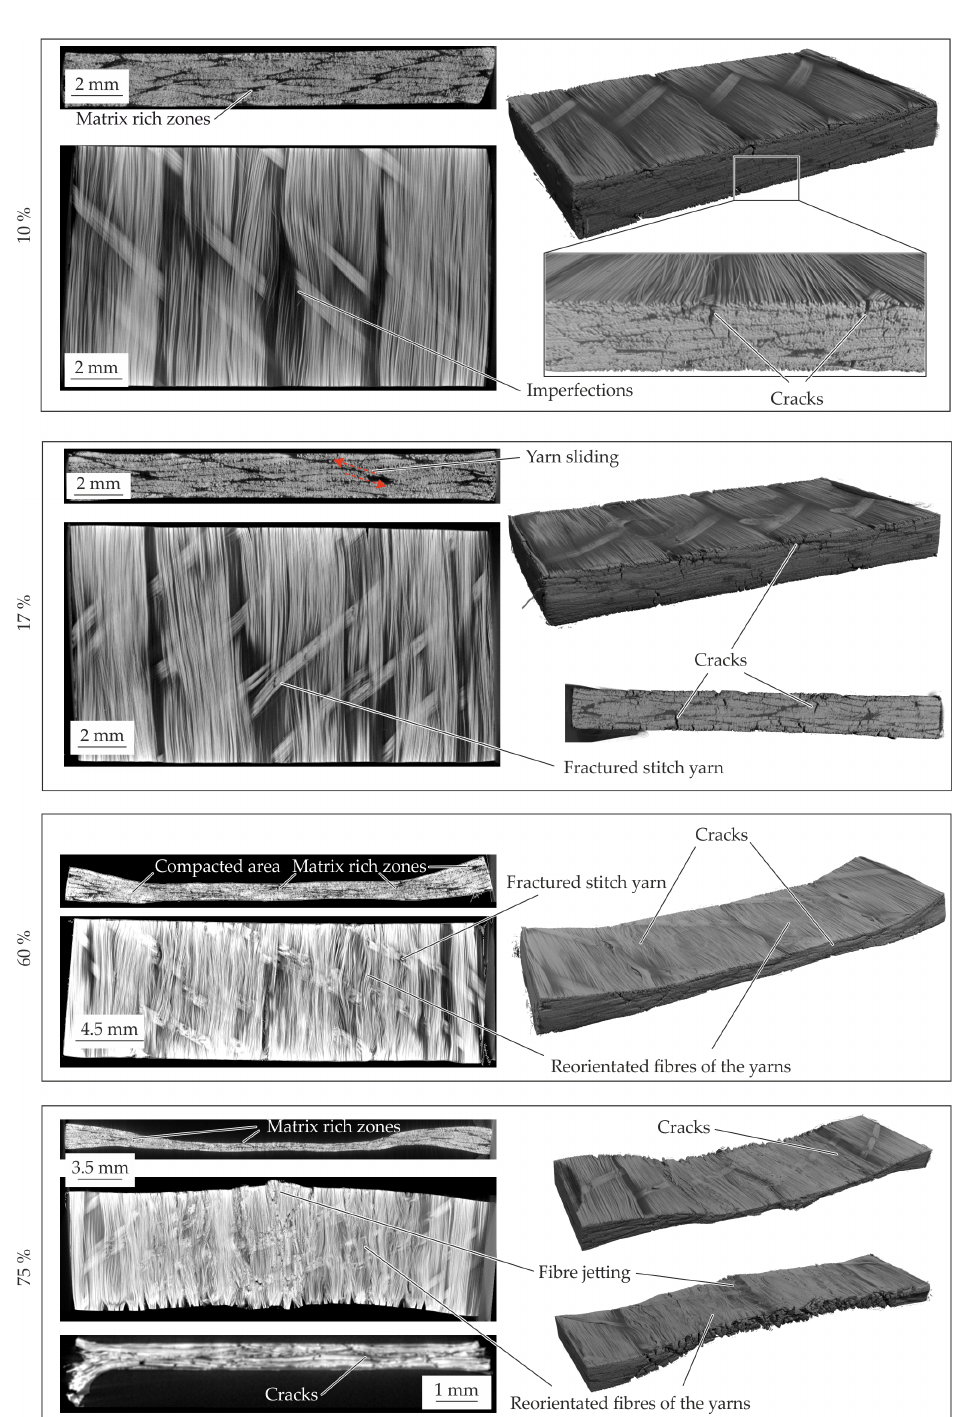
Figure 14. CT analysis of the 2mm–configuration for the different compaction levels at